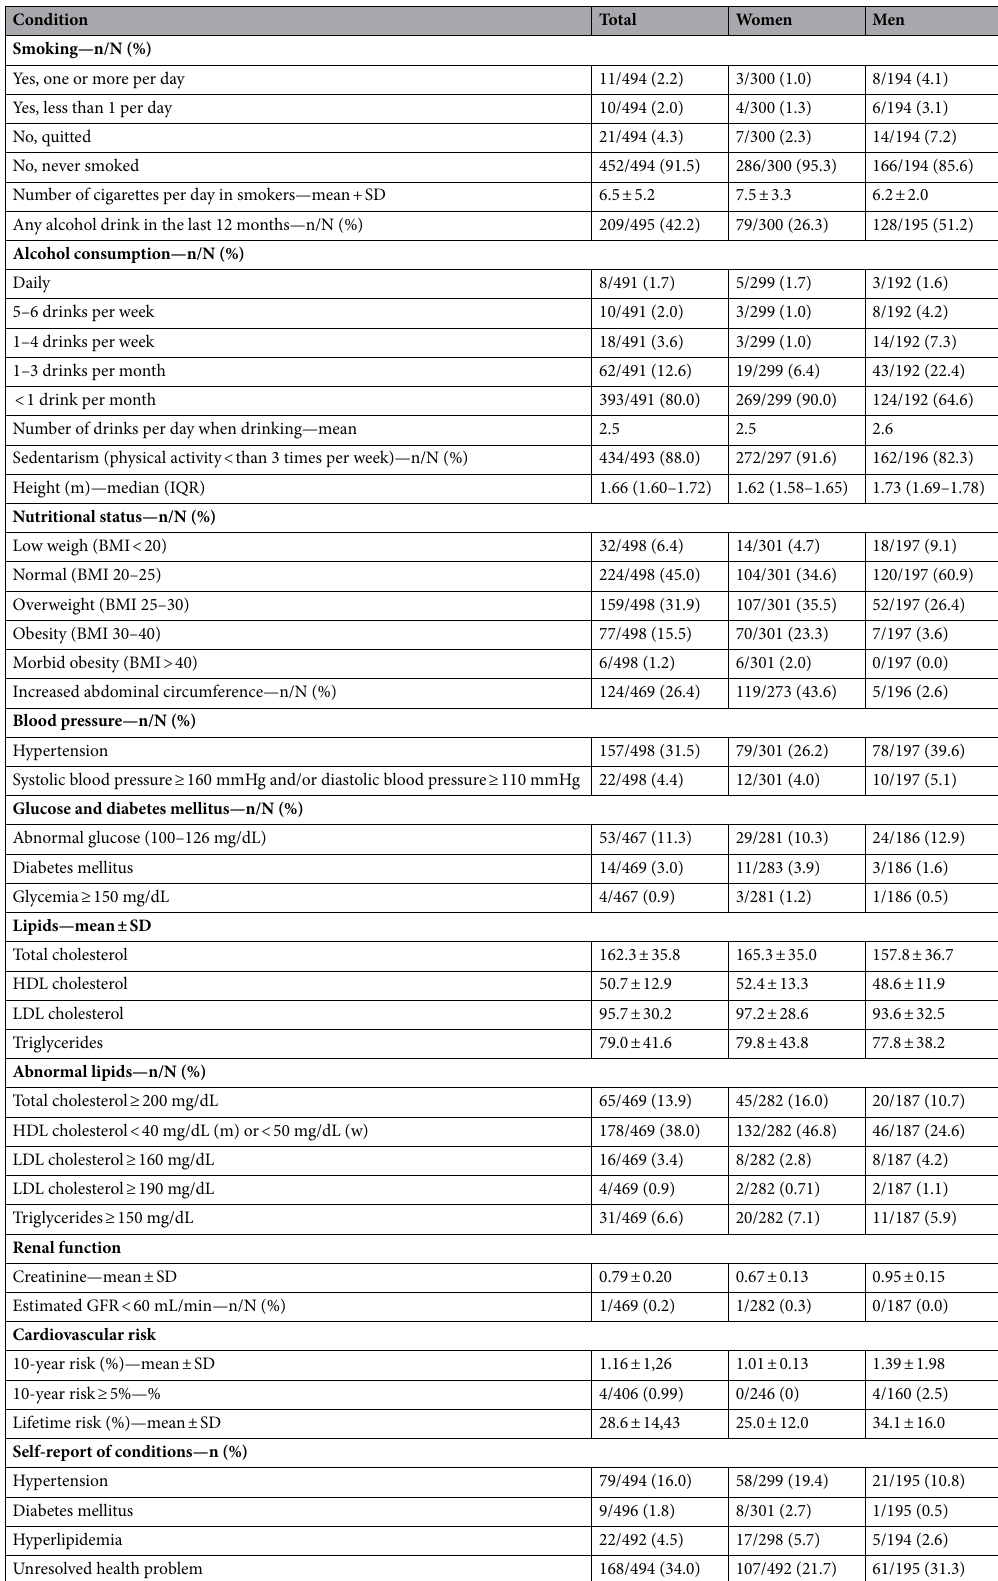
Table 2. Prevalence of selected conditions and anthropometry. SD: Standard deviation, IQR: Interquartile